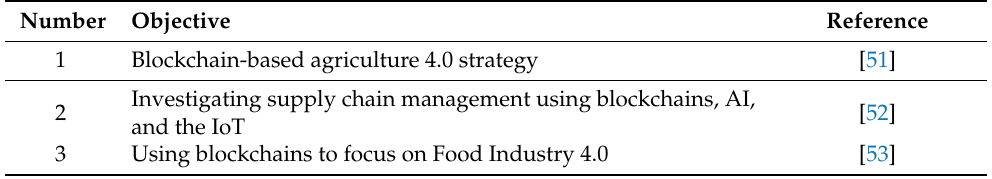
Table 2. Agriculture using blockchains and